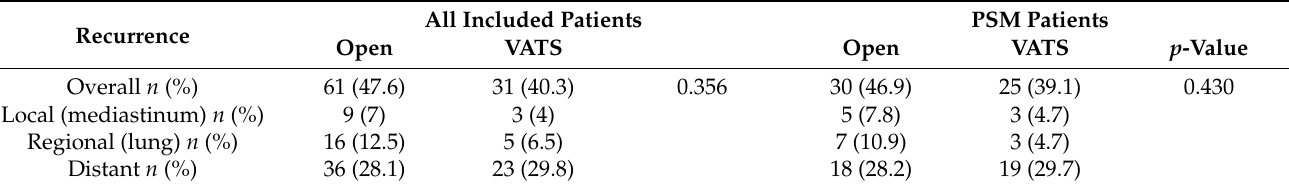
Table 4. Patterns of recurrence of all included patients and PSM